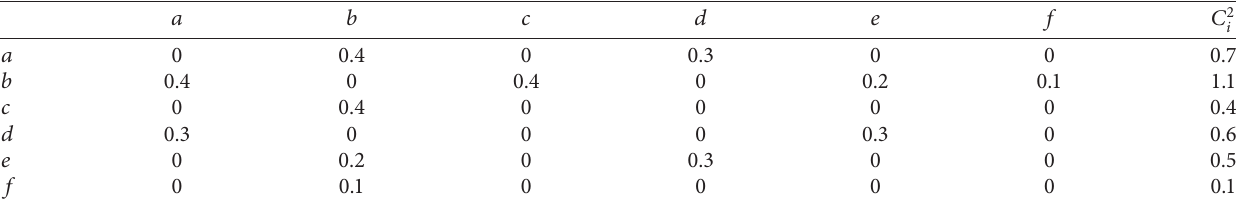
Table 5: The tabular representation of Z ∗ ( d ) with choice values.